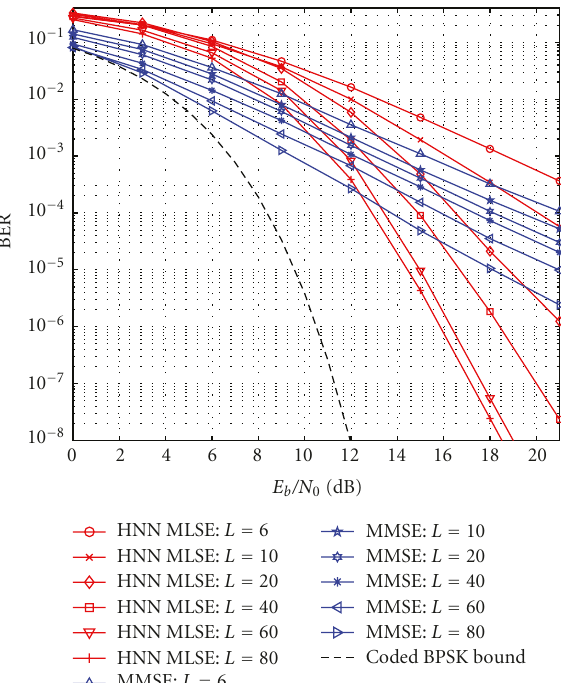
Figure 16: BPSK HNN MLSE and MMSE equalizer performance